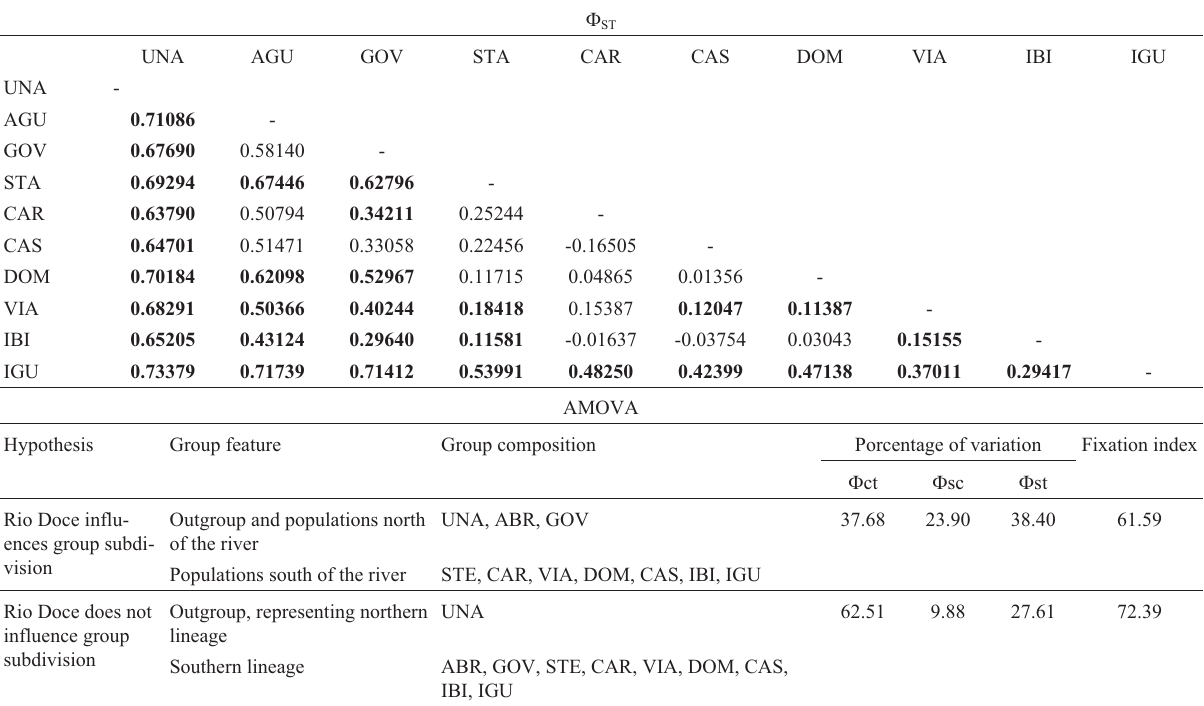
Table2 -Geneticstructureofthe A.cursor populations.Upperhalfoftable:pairwise (cid:4) ST (geneticdifferentiationbetweenpopulations).Lowerhalfofta- ble:Analysisofmolecularvariance(AMOVA)totesttwohypotheticalscenariosforthepartitioningofgeneticvariationusingthefixationindicesamong groups ( (cid:4) ct), among populations within groups ( (cid:4) sc) and within populations ( (cid:4) st). Significant p-values (p < 0.05) are highlighted in bold. UNA (Bahia) was used to polarize the analysis and represent the northern lineage in A. cursor (see Figure